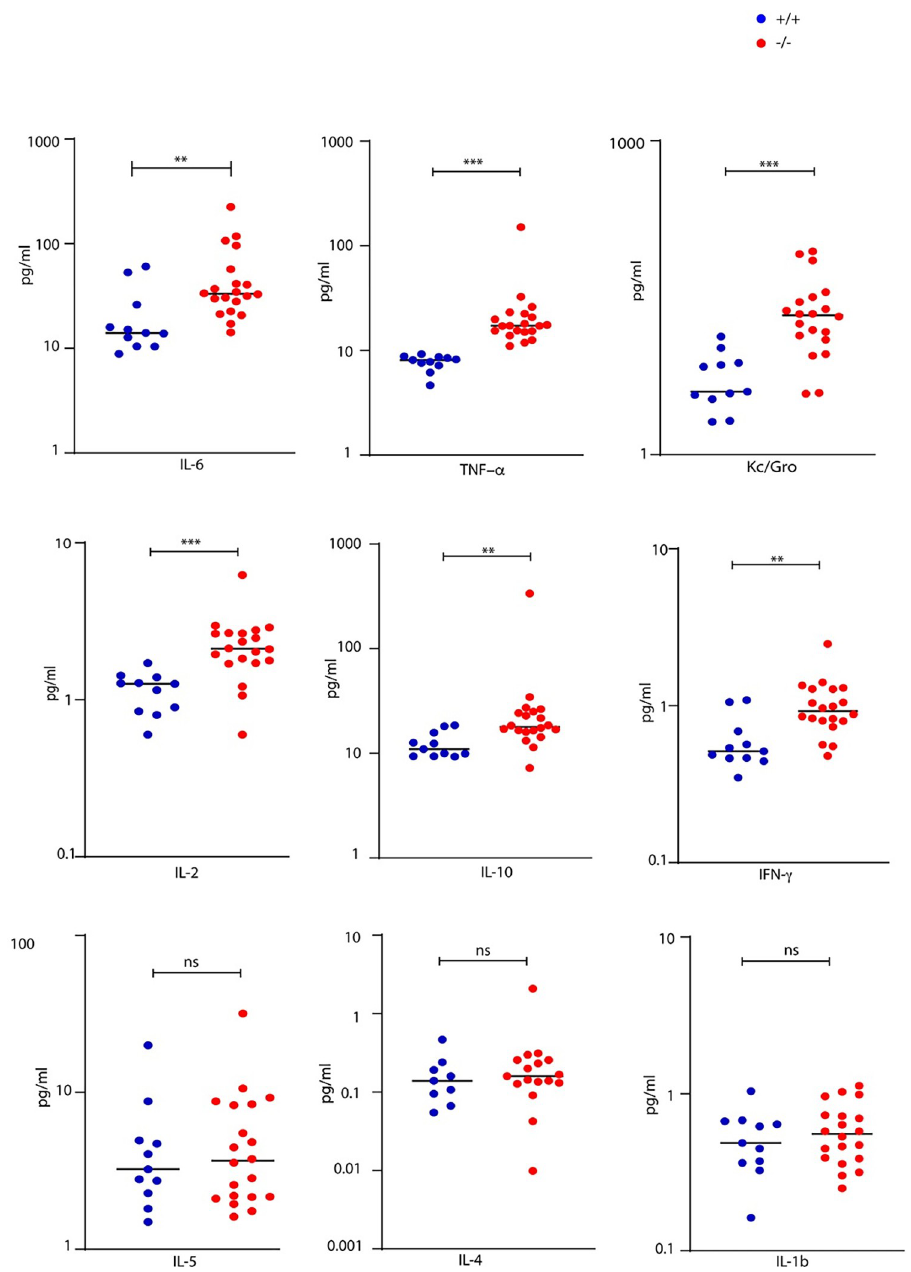
Fig 4. Measurement of cytokines. Multiplex measurement of the proinflammatory cytokines IL-6, TNF- α , KC/ GRO, IL-2, IL-10, IFN- γ , IL-5, IL-4 and IL-1b was performed in plasma of control and Mgme1 -/- mice. Aged Mgme1 -/- mice accumulate several proinflammatory cytokines in